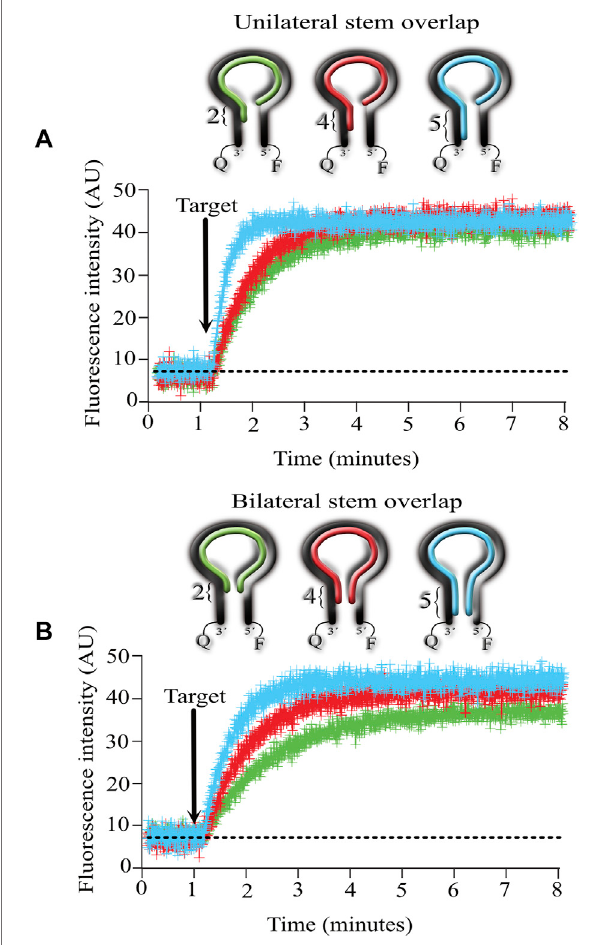
FIGURE 4 | Effect of overlapping the stem with the target complementary sequence on the kinetics of MB-targe association. (A) , target overlapping2(green),4(red)and5(lightblue)nucleotidesofthestemfromthe MBinthe3 ′ direction(unilateral). (B) ,targetoverlapping2(green), 4(red) and 5 (light blue) nucleotides of the stem from the MB in the 3 ′ and 5 ′ directions (bilateral). Values show the mean ± standard deviation from 6 independent microarrays, measuring the mean fl uorescence from at least 6 spots for each